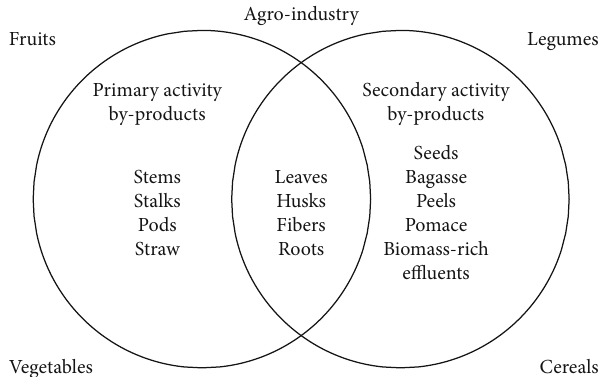
Figure 1: Agroindustry